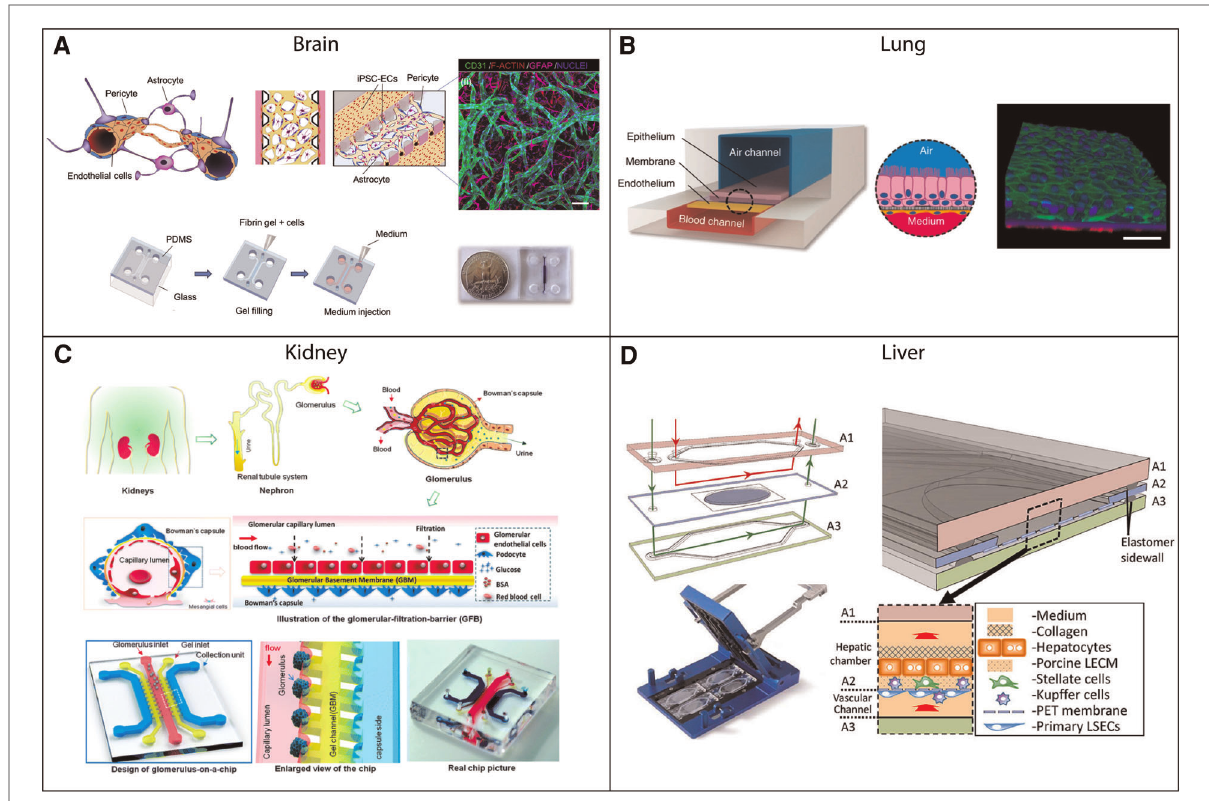
FIGURE 2 Examples of vascularized tissue chips for different organ systems. ( A ) Tissue chip example of the blood-brain barrier (BBB). The 3D-BBB contains a microvascular network that forms through a fi brin gel via vasculogenesis. Adapted from (31) with permission; copyright Elsevier Science & Technology Journals. ( B ) Small airway-on-a-chip example. The tissue chip contains blood and air channels separated by a porous membrane. Pulmonary microvascular endothelial cells line the blood channel and are exposed to fl uid fl ow. Adapted from (32) with permission; Copyright © 2015, Nature Publishing Group, a division of Macmillan Publishers Limited (CC-BY). ( C ) Example of a glomerulus-on-a-chip. The chip contains capillary, gel, and collection channels, with glomerular endothelial cells cultured in the capillary channel and exposed to fl uid fl ow. Adapted from (33) with permission from Royal Society of Chemistry. ( D ) Tissue chip example of the liver. Liver sinusoidal endothelial cells and Kupffer cells are cultured in a vascular chamber, which is separated from a hepatic chamber by a porous membrane. Both chambers have fl uid fl ow rates that are representative of the fl ow experienced in vivo . Adapted from (34) with permission from the Royal Society of